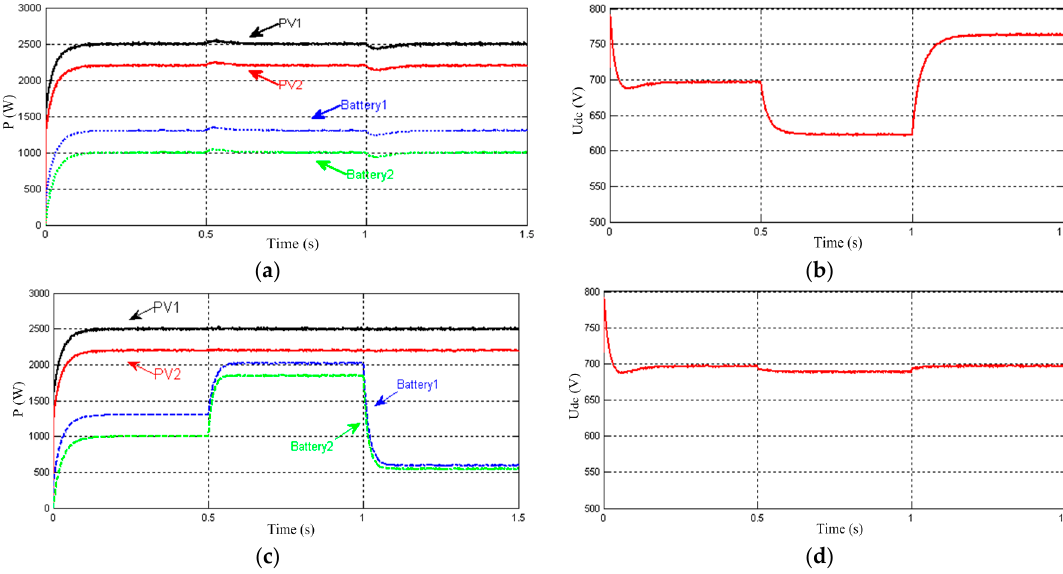
Figure 10. Simulated results of case 2: ( a ) output power without Droop ‐ 2 control; ( b ) DC bus voltage without Droop ‐ 2 control; ( c ) output power with Droop ‐ 2 control; and ( d ) DC bus voltage with Droop ‐ 2 control.